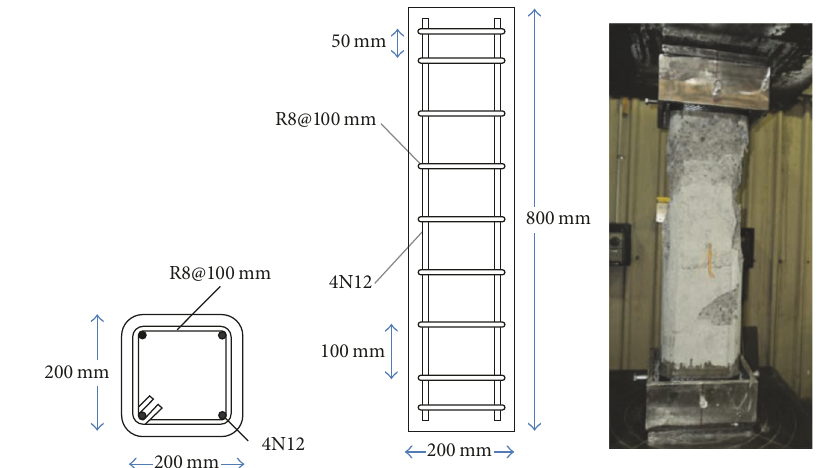
Figure 11: Column sample selected for validation [17].